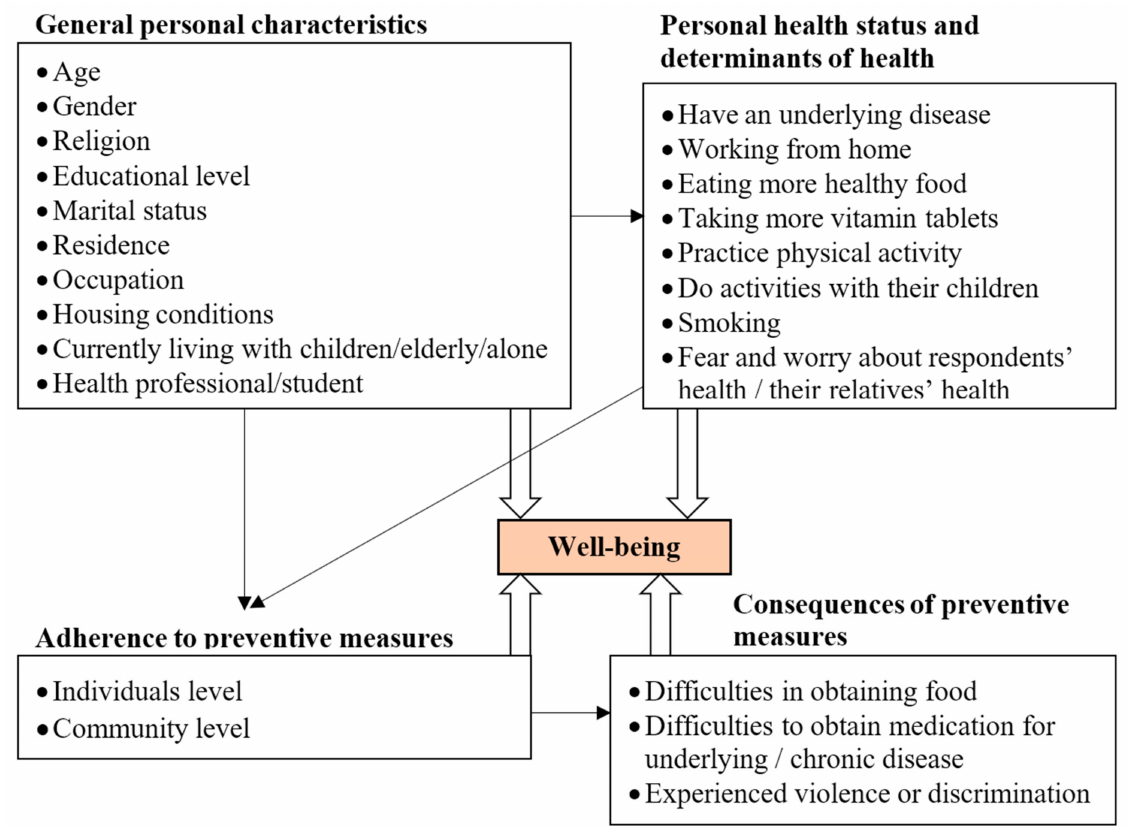
Figure 1. Conceptual framework of the factors associated with well-being during the COVID-19